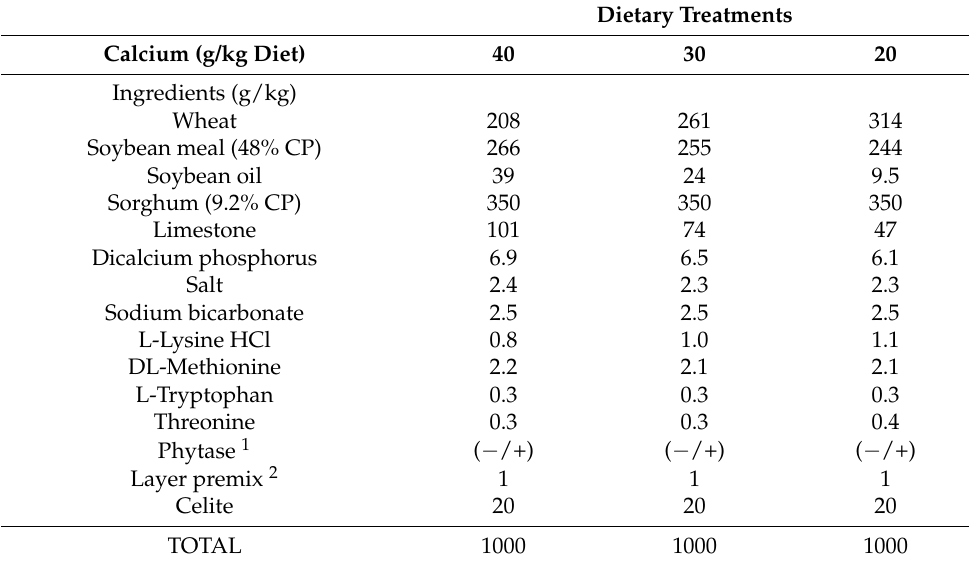
Table 1. Ingredient composition of experimental diets (as fed).